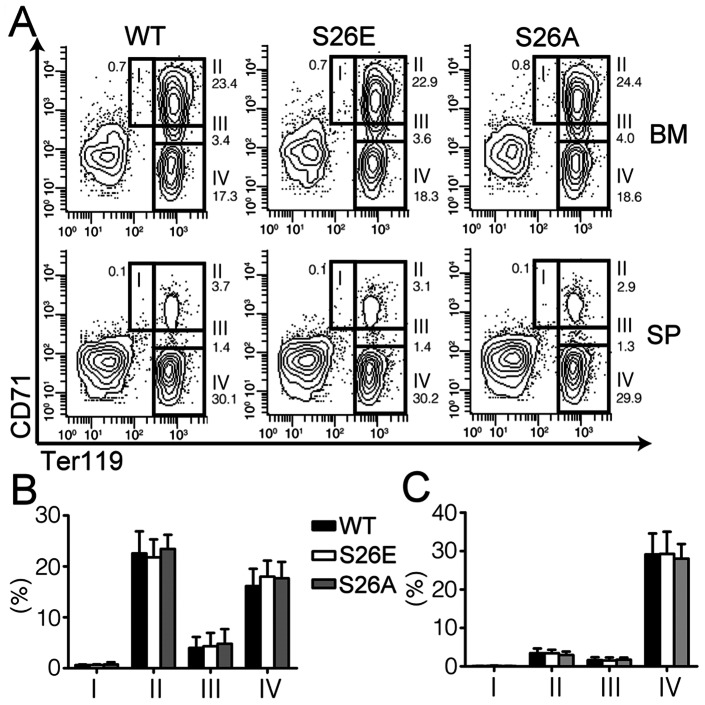
Lack of effect of serine26 mutations on the development of erythroblasts.(A) Representative FACS profiles of the erythroblast population in adult BM and spleen (SP) from wild-type (WT), GATA-1S26E (S26E), and GATA-1S26A (S26A) male mice. Four erythroblast stages (I–IV) were defined by the combined differential expression of CD71 and Ter119 as follows: stage I, proerythroblasts (CD71high/Ter119med); stage II, basophilic erythroblasts (CD71high/Ter119high); stage III, late basophilic and polychromatophilic erythroblasts (CD71med/Ter119high); and stage IV, orthochromatic erythroblasts (CD71low/Ter119high). The percentages of erythroblast at each stage as indicated in (A) are shown in (B) for the BM and (C) for the spleen. All data are shown as mean ± SD (n = 9–10 for each genotype). The P values for all four stages among the three genotypes are >0.1.